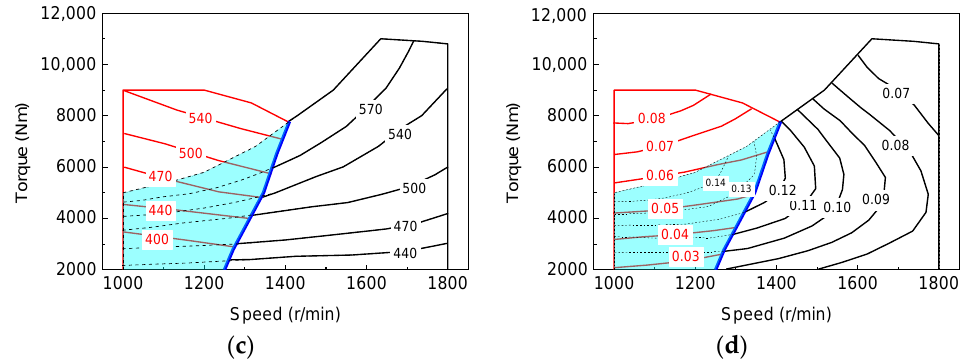
Figure 9. Matching characteristics of the STC system. ( a ) extended area. ( b ) contour of the BSFC. ( c ) contour of the exhaust temperature. ( d ) contour of the smoke opacity.